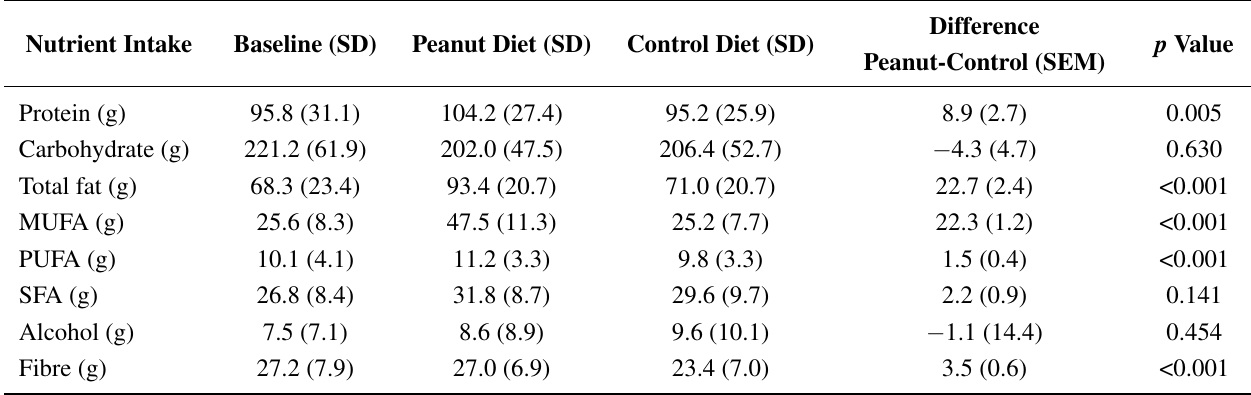
Table 2. Effect of daily high oleic peanut consumption and nut free diet on macronutrients, fibre and alcohol intakes.